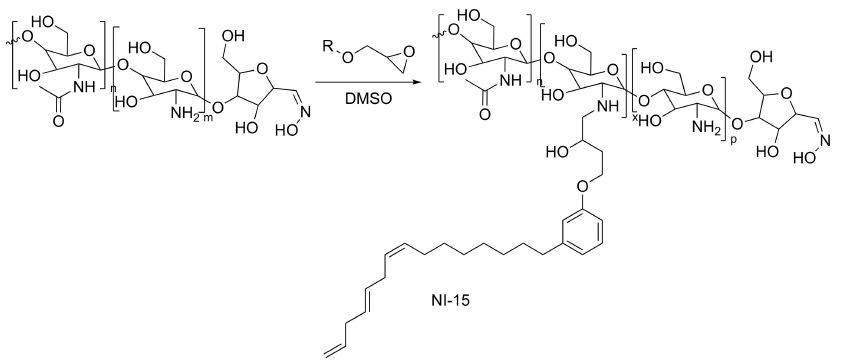
glycosylation was carried out between cardanol (NI-16), cardol (NI-17) or anacardic acid